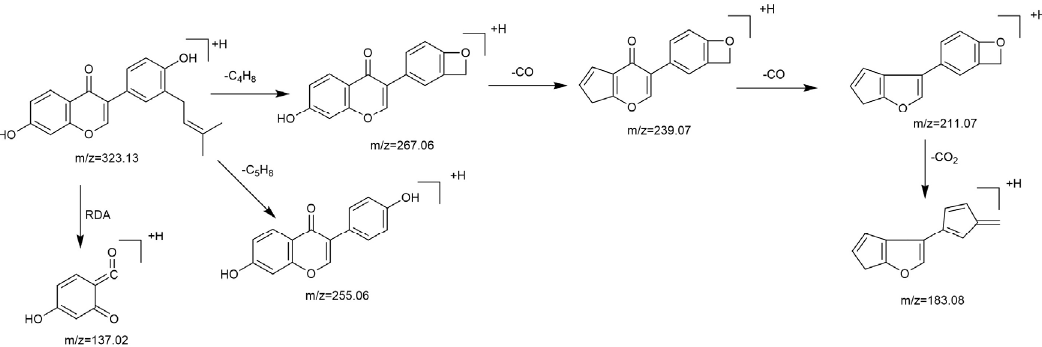
Figure 4. The proposed fragmentation pathways for neobavaisoflavone in the positive ion mode. Table 1. Mass spectral information of neobavaisoflavone in rat plasma, urine, feces, liver, and liver microsome.